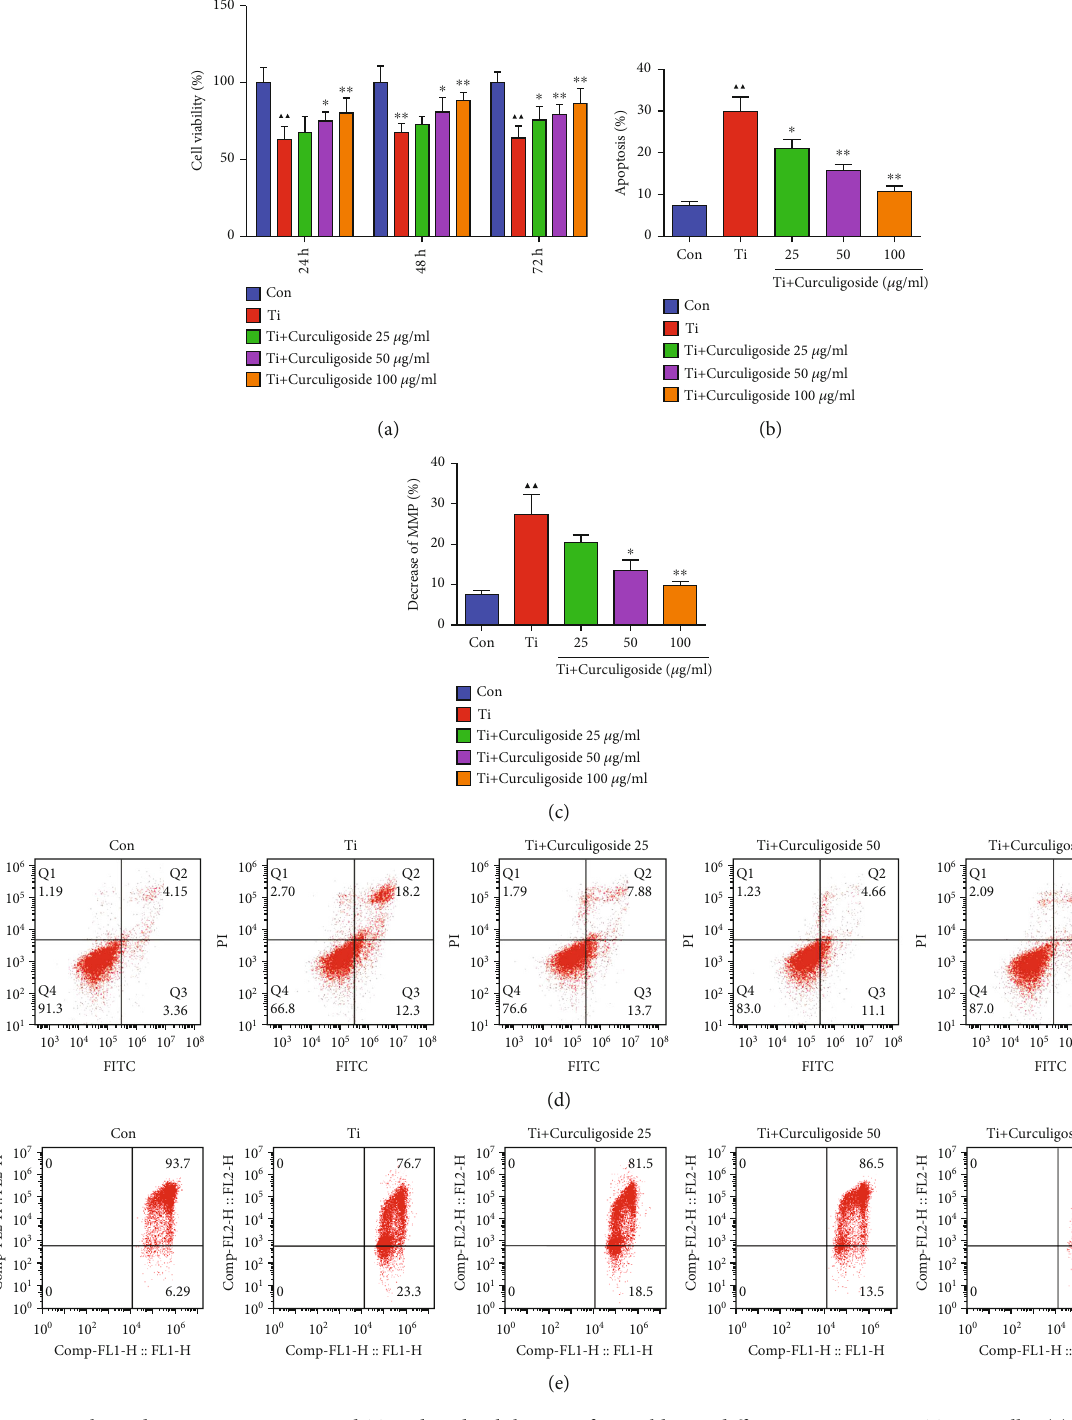
Figure 1: Curculigoside treatment attenuated Ti-induced inhibition of osteoblastic di ff erentiation in MC3T3-E1 cells. (a) After being intervened with Ti and treated with curculigoside at di ff erent concentrations (25, 50, and 100 μ g/ml) for 24 h, 48 h, and 72h, MC3T3-E1 cell viability was detected by the CCK-8 assay ( n = 6 ). (b, d) After being intervened with Ti and treated with curculigoside, cell apoptosis was detected by fl ow cytometry ( n = 3 ). (c, e) Mitochondrial membrane potential of MC3T3-E1 cells cultured under Ti and di ff erent concentrations of curculigoside was assayed by fl ow cytometry using JC-1 assay kits, and the decrease in the MMP index in each group cell was quanti fi ed ( n = 3 ). Results are represented as the mean ± SD . ▲ P < 0 : 05 , compared to the Con group; ▲▲ P < 0 : 01 , compared to the Con group; ∗ P < 0 : 05 , compared to the Ti group; ∗∗ P < 0 : 01 , compared to the Ti group. Ti: titanium particle; Con: control; MMP: mitochondrial membrane